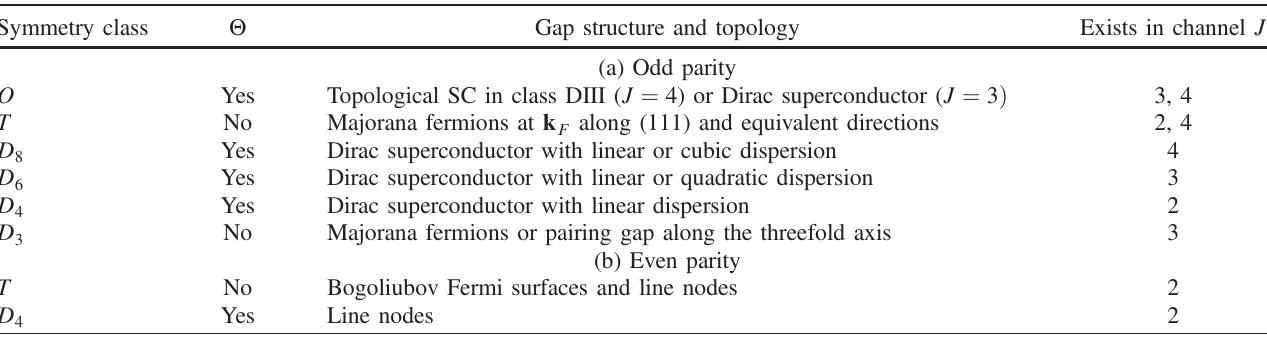
TABLE V. Pairing states with discrete symmetry. Summary of the considered gap structures of pairing states with discrete symmetry. The first column lists the symmetry classes discussed in this section; the presence or absence of time-reversal symmetry for states with given symmetry is indicated. The final column indicates in which pairing channel, labeled by J , pairing states with given symmetry exist. We explicitly distinguish even- and odd-parity pairing. We focus only on pairing channels J which can be formed up to p -wave order, i.e., L ¼ 1 ; see Table I.